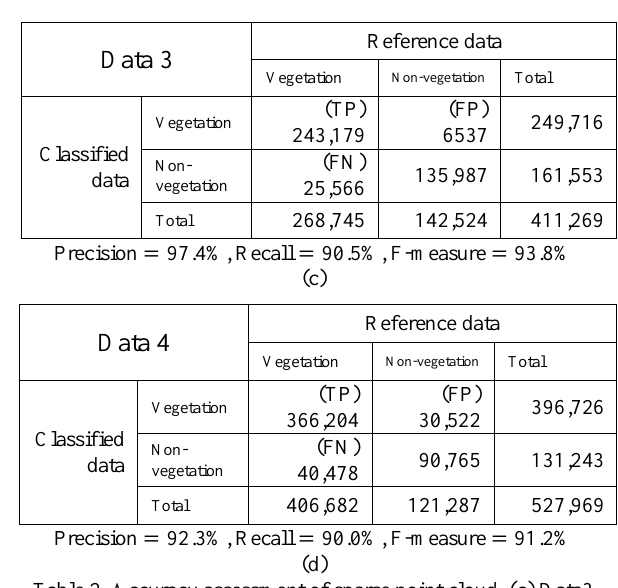
Table 2. Accuracy assessment of sparse point cloud, (c) Data3 and (d) Data 4 (Unit: